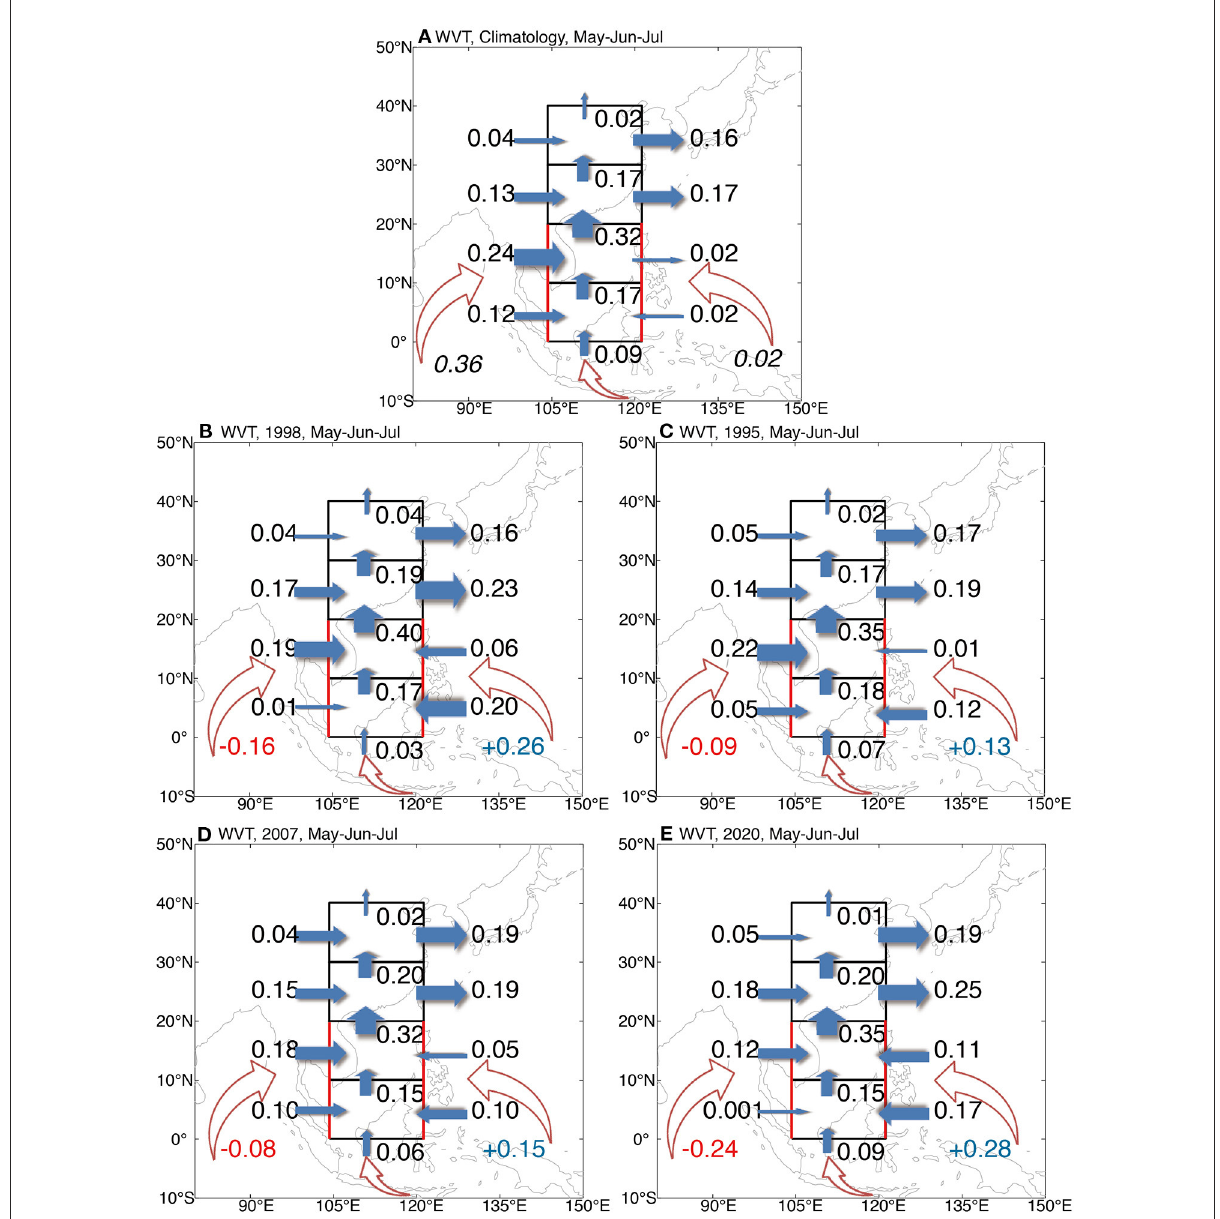
FIGURE13 Water vapor transport (blue arrows, Sv) through boundaries (black lines) and the water vapor transport anomalies (red arrows, Sv) through boundaries (red lines) from the Indian Ocean and the Pacific of climatology (A) , 1998 (B) , 1995 (C) , 2007 (D) , and 2020 (E) . The data were from